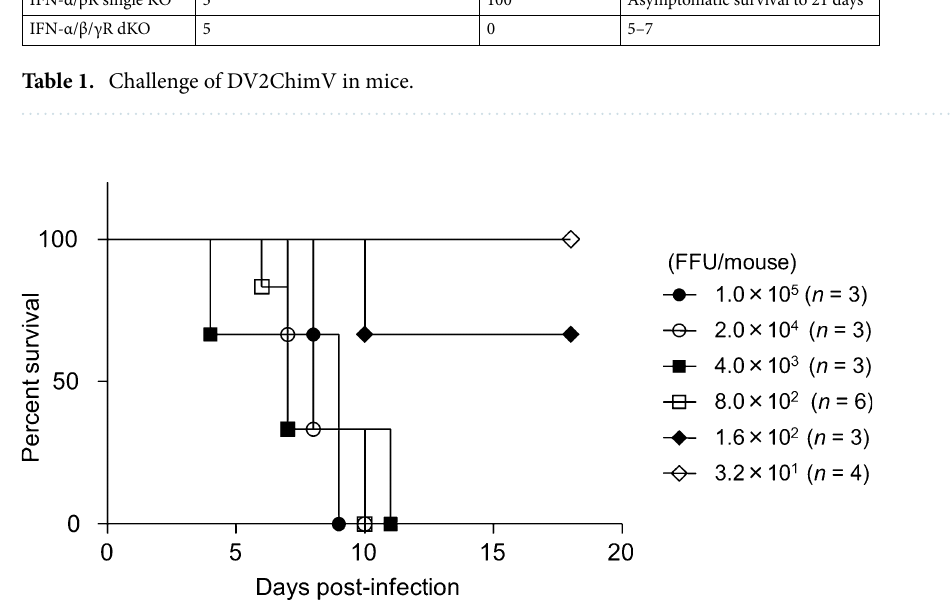
Figure 2. Survival rates of mice infected with chimeric flavivirus. Groups of IFN-α/βR–γR double-knockout mice (8–9 weeks old) were intraperitoneally infected with DV2ChimV at doses ranging from 3.2 × 10 1 to 1.0 × 10 5 focus-forming units per mouse (FFU/mouse), and their survival was monitored. Kaplan–Meier survival curves show the percentage of mice surviving at the specified days post-infection. Statistical differences were evaluated by the Log-rank (Mantel–Cox) test. P =